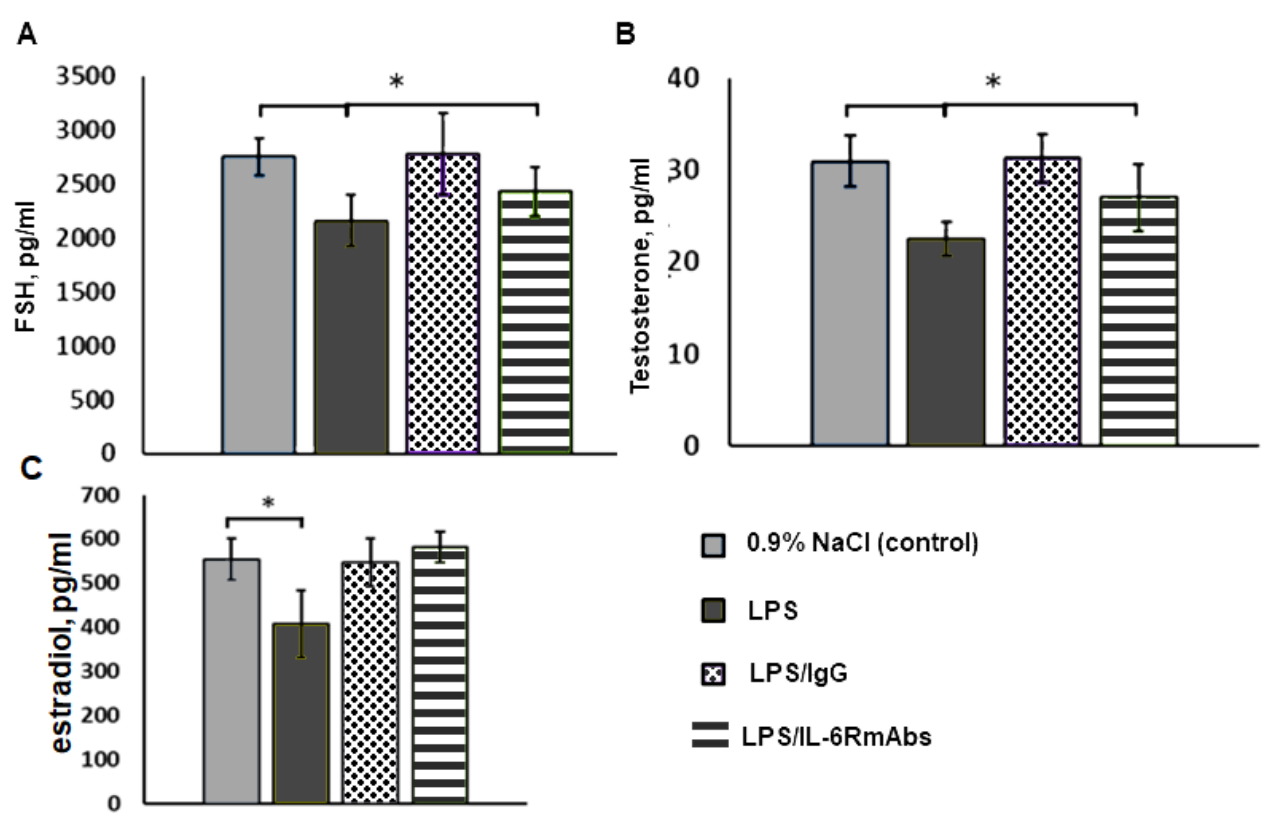
Figure 4. Plasma FSH ( A ), testosterone ( B ), and estradiol ( C ) levels in males on PND80 exposed on ED12 to 0.9% NaCl (control); LPS; LPS and IgG; and LPS and IL-6RmAbs (n = 10 animals per group). M ± SEM, * p < 0.05 between groups.